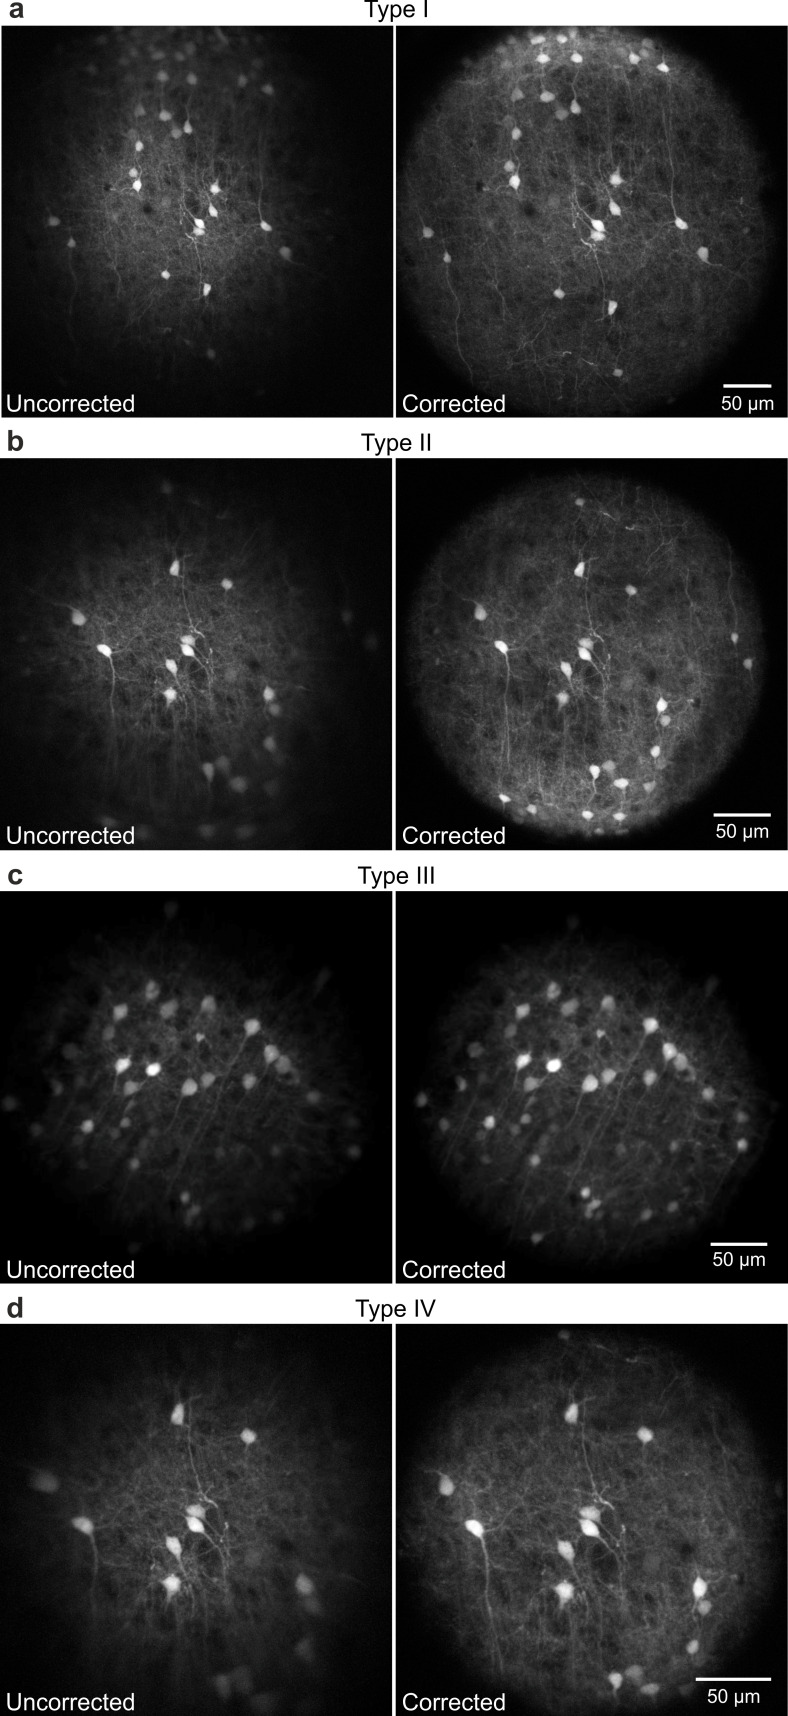
Corrected microendoscopes have extended effective FOV.(a-d) Representative images of fixed cortical tissue expressing eGFP in neuronal cells acquired with type I (a), type II (b), type III (c), and type IV (d) microendoscopes without (uncorrected, left panels) and with (corrected, right panels) corrective lenses.